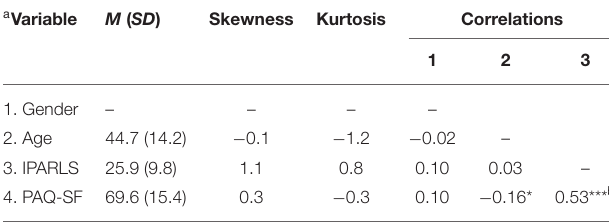
TABLE 6 | Hierarchical multiple regression analyses predicting psychological maladjustment from gender, age and loneliness (IPARLS; N =